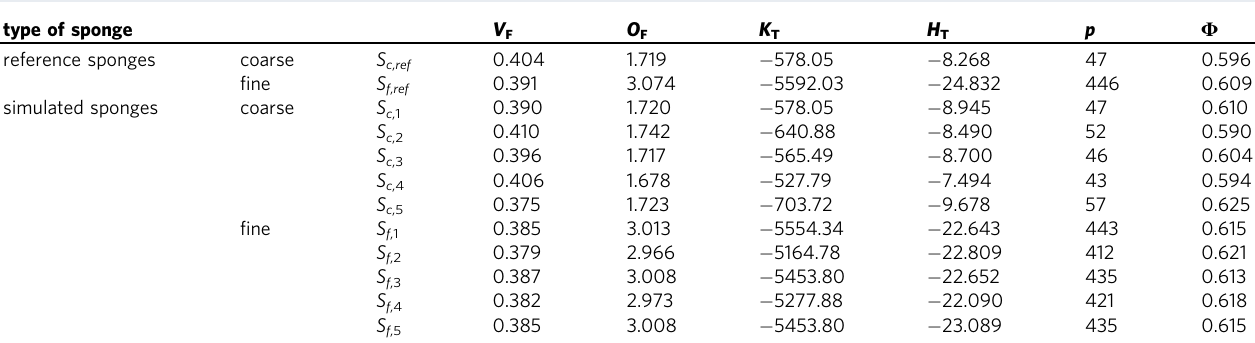
Table 1 Comparison of the experimentally determined geometric properties of the reference sponges with those obtained by means of phase- fi eld